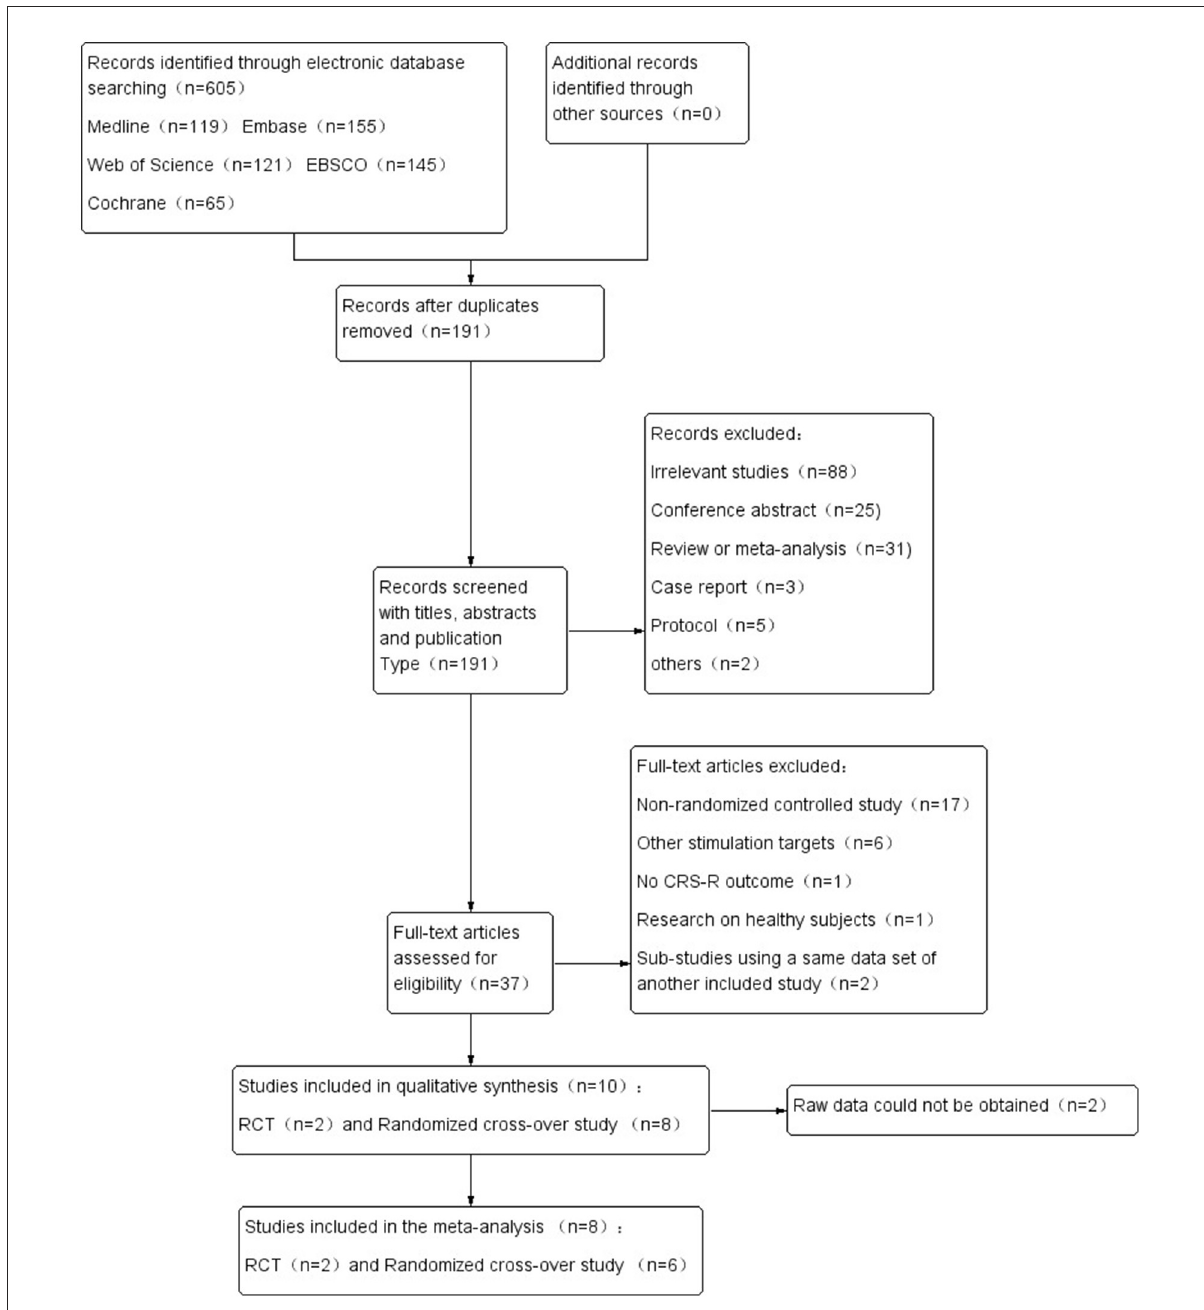
FIGURE1 Study flow